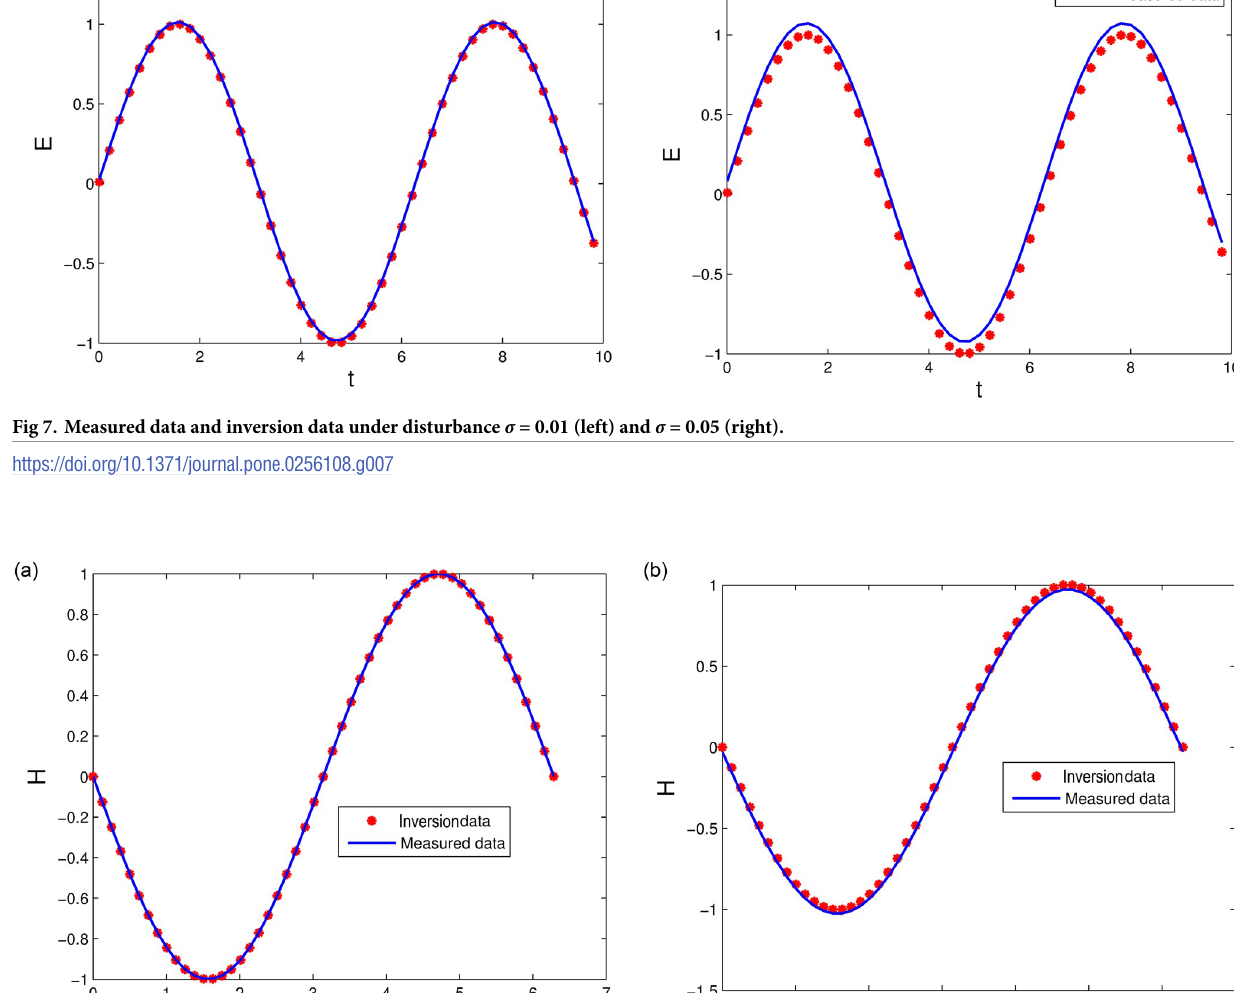
Table 1 lists the inverting parameter ε � under different distribution σ . Figs 7 and 8 show measured data and inversion data with x = π , t 2 [0, 10] and x 2 [0, 2 π ], t = 0.5, respectively. The results show that the inversion data is consistent with measured data. The inverting parameters estimated by least square method and LODEFMS scheme are reasonable under small disturbance error.